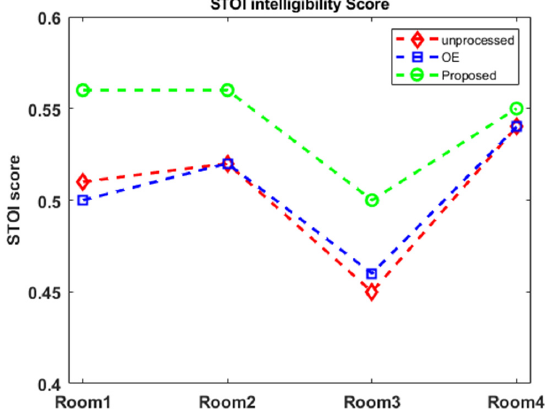
Figure 4. The STOI scores for the main scenario in each room for reverbed unprocessed, reverbed OE-enhanced, and the reverbed enhanced signal with the proposed algorithm. The proposed algorithm shows improvement for the STOI score in comparison to the reverbed unprocessed and OE- enhanced signals.